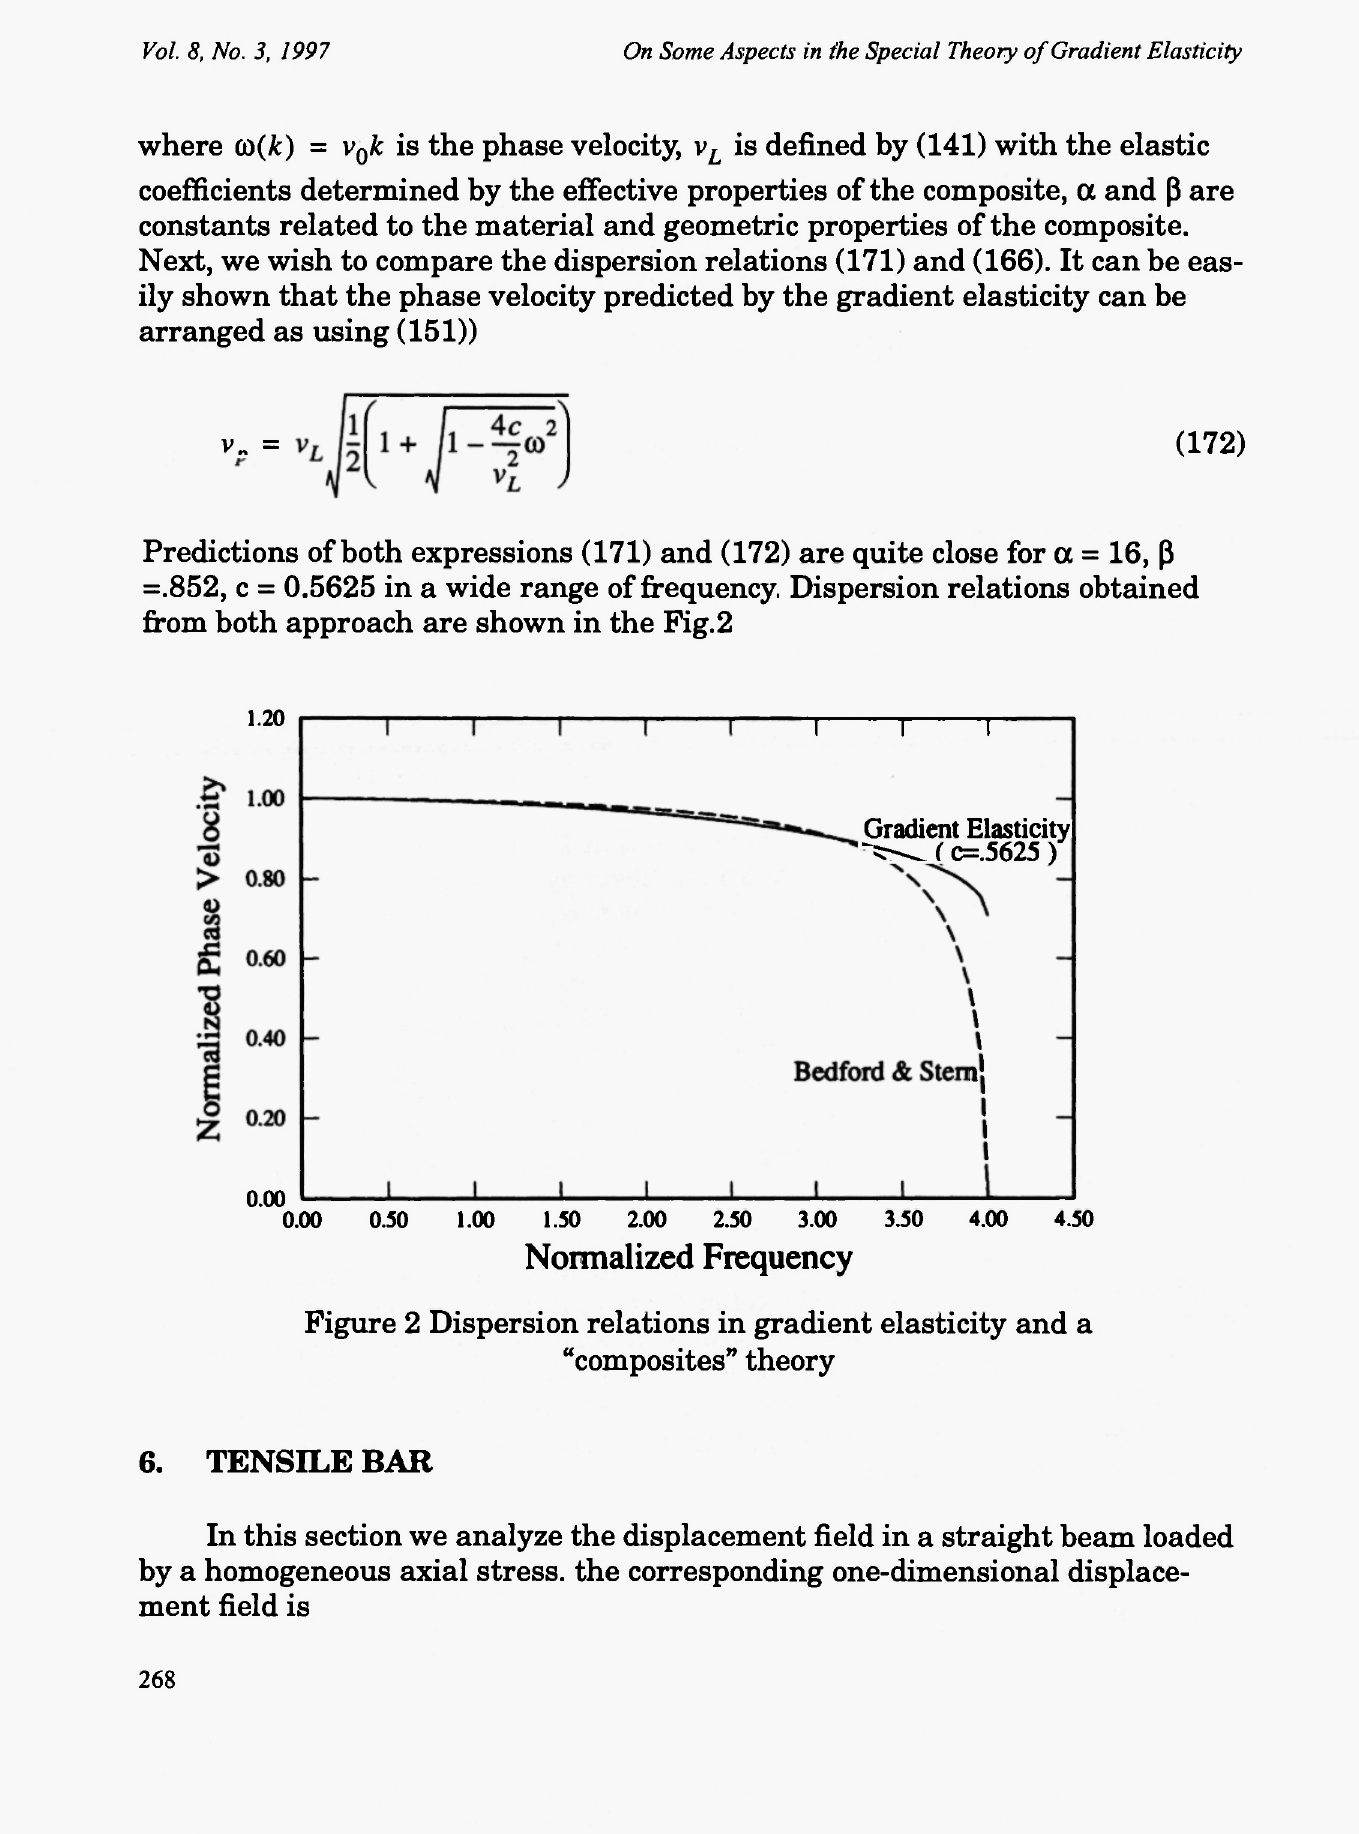
Figure 2 Dispersion relations in gradient elasticity and a "composites"